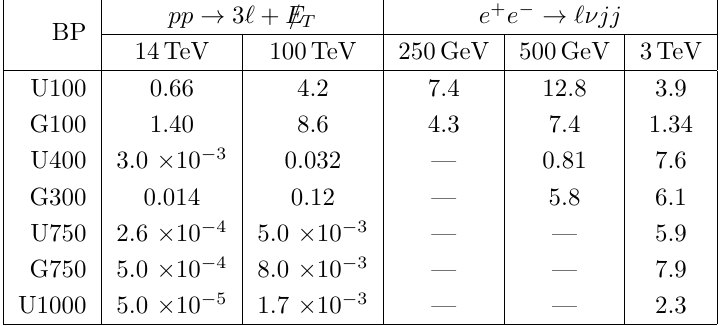
Table 3 . Cross sections of CW neutrino signatures at hadron and lepton colliders, before selection cuts (in fb). Acceptance cuts have been applied at the parton level: (cid:1) R pairs; p T ( ‘ ) 10(20) GeV for hadron (lepton) colliders; p T ( j ) (cid:21)